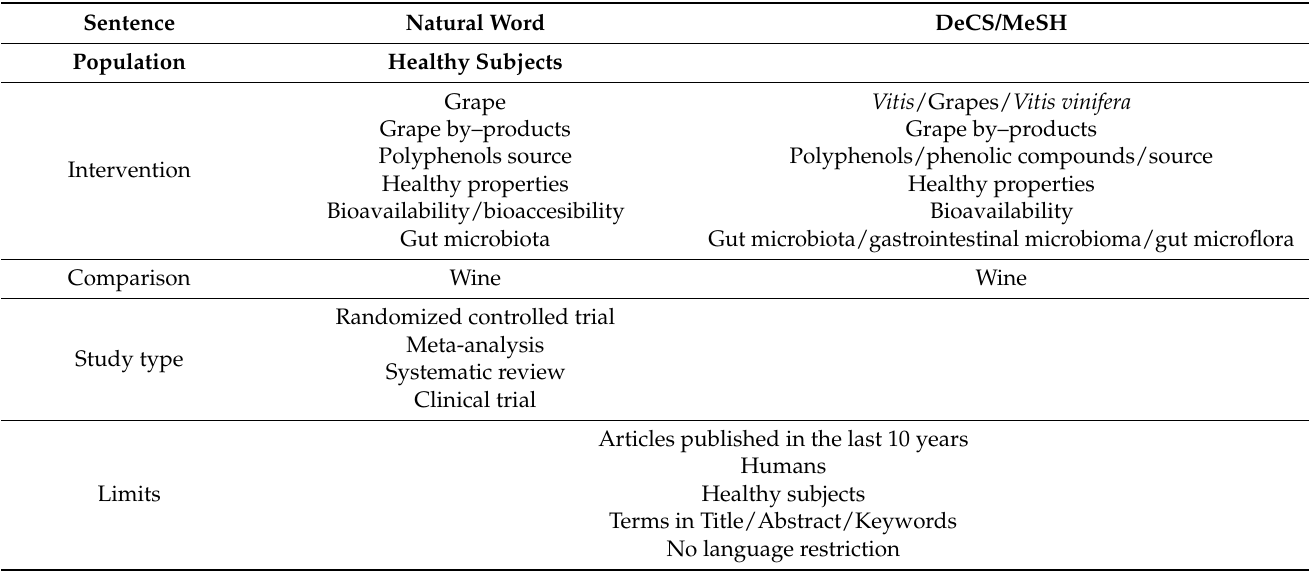
Table 2. DeCS and MeSH descriptors according to PICO format on grape, grape by-products polyphenols, gut microbiota and